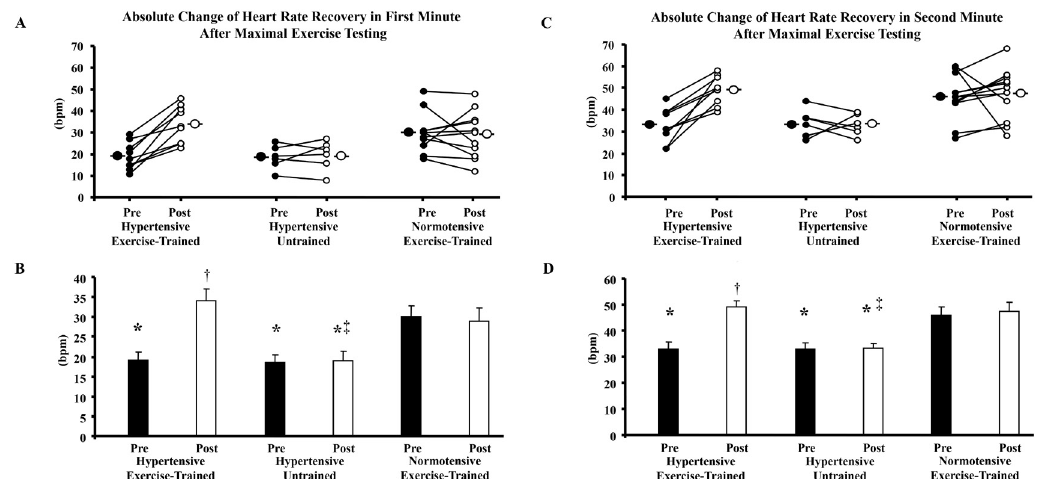
Figure 3. The decline rate of heart rate recovery (HRR) in first (Panel A and B) and second (Panel C and D) minutes after maximal exercise testing, in exercise-trained hypertensive patients, untrained hypertensive patients, and exercise-trained normotensive individuals. Note that exercise training significantly increased the decline rate of heart rate recovery (HRR) in first (Panel A and B) and second (Panel C and D) minutes after maximal exercise testing in hypertensive patients. *= Significant difference vs. normotensive individuals; †= Significant difference pré- vs. post interventions; ‡= Significant difference vs. exercise-trained hypertensive patients,